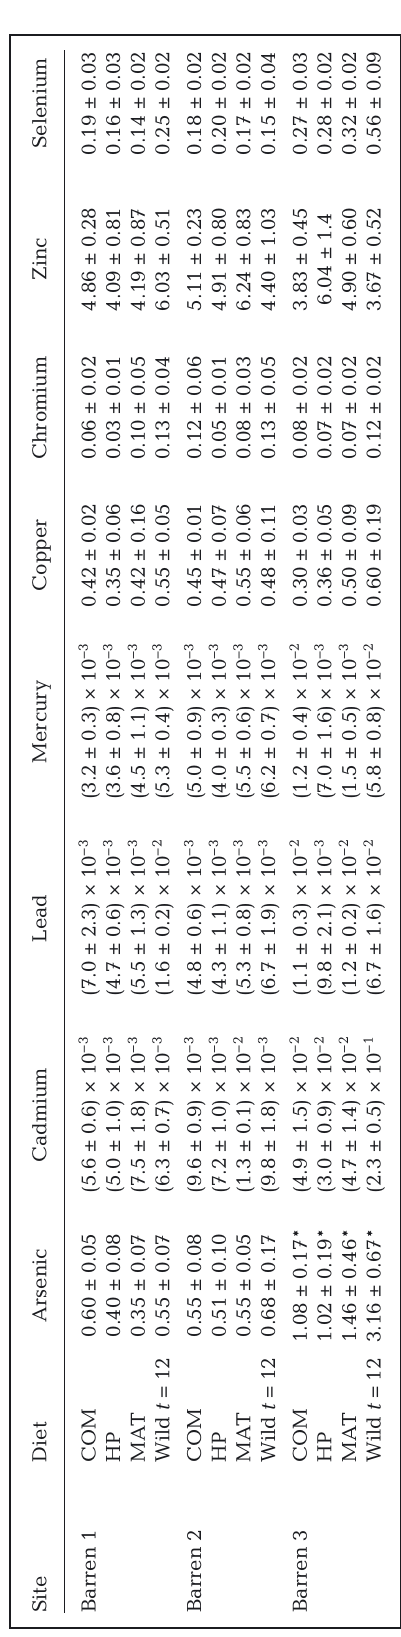
Table 5. Expt 2: 2-way ANOVA for metal concentrations in the gonadal tissue of Heliocidaris erythrogramma (n = 6) from urchin barrens in Port Phillip Bay that were fed manu- factured diets or remained in the wild for 12 wk. A Bonfer- roni correction was used to account for multiple tests ( α = 0.00625). Cadmium, Selenium, Lead (207): log transformed; Arsenic, Chromium, Mercury (200): 4th-root transformed; *p < 0.05; **p <